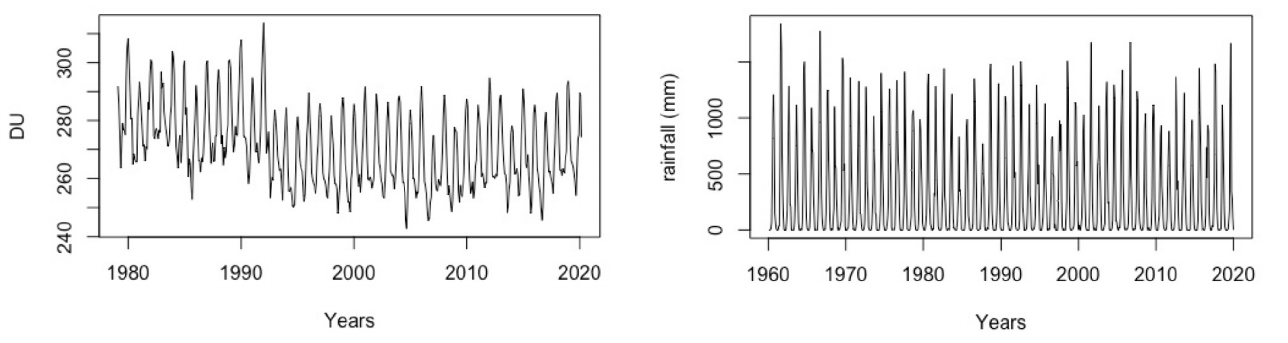
Figure 4. Monthly time series of total ozone columns in Dobson units (DU) over Réunion from 1979 to 2019. The time axis is ex- pressed in years.